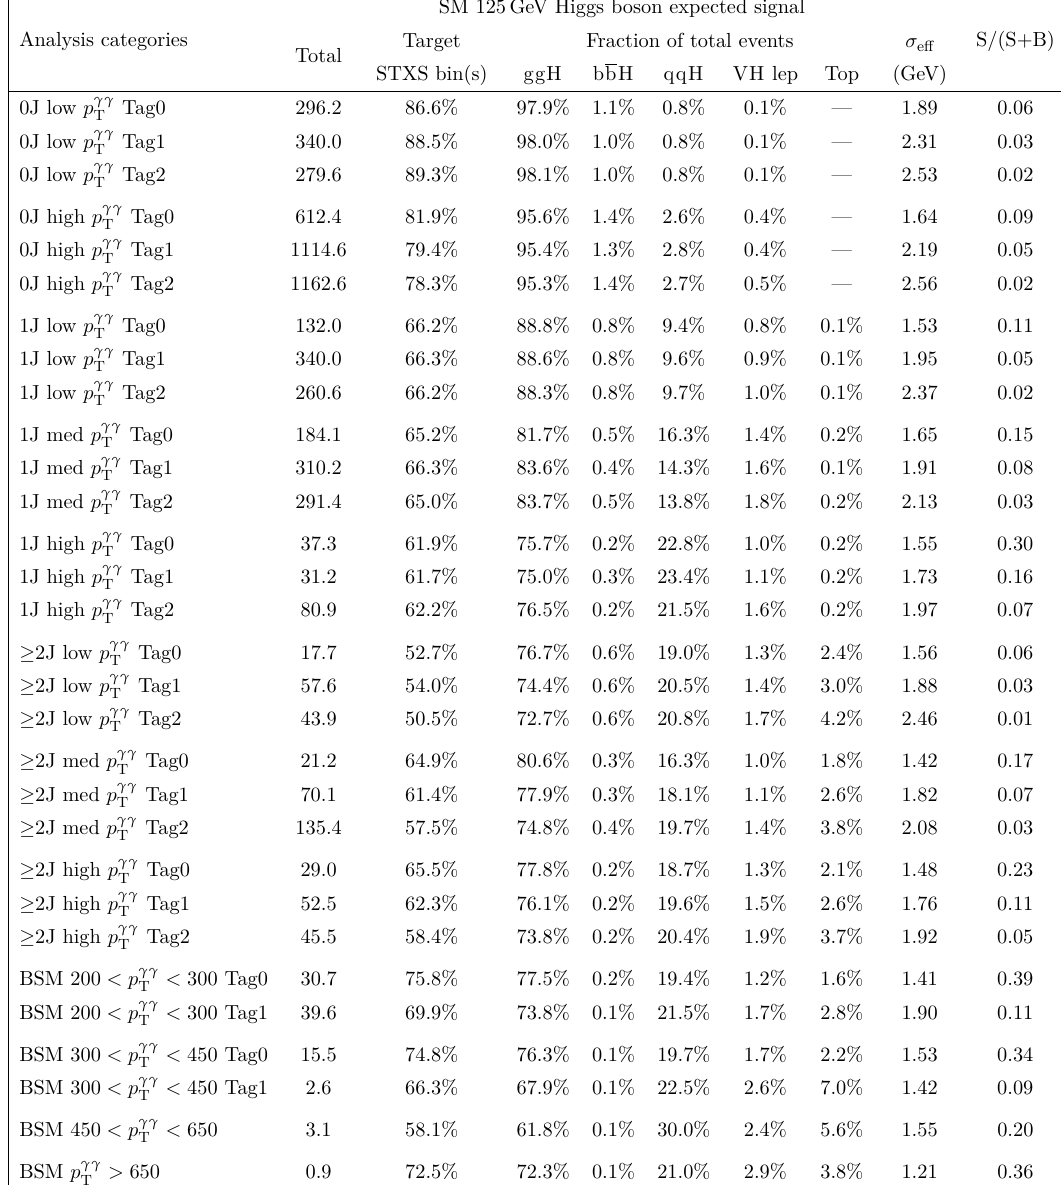
= 125 GeV in analysis categories targeting Table 3 . The expected number of signal events for m H ggH production, excluding those targeting the VBF-like phase space, shown for an integrated luminosity of 137 fb − 1 . The fraction of the total number of events arising from each production mode in each analysis category is provided, as is the fraction of events originating from the targeted STXS bin or bins. Entries with values less than 0.05% are not shown. Here qqH includes contributions from both VBF and hadronic VH production, whilst “Top” includes ttH and tH together. The , defined as the smallest interval containing 68.3% of the m distribution, is listed for each σ eff gg analysis category. The final column shows the expected ratio of signal to signal-plus-background, S/(S+B), where S and B are the numbers of expected signal and background events in a ± 1 σ eff window centred on m H